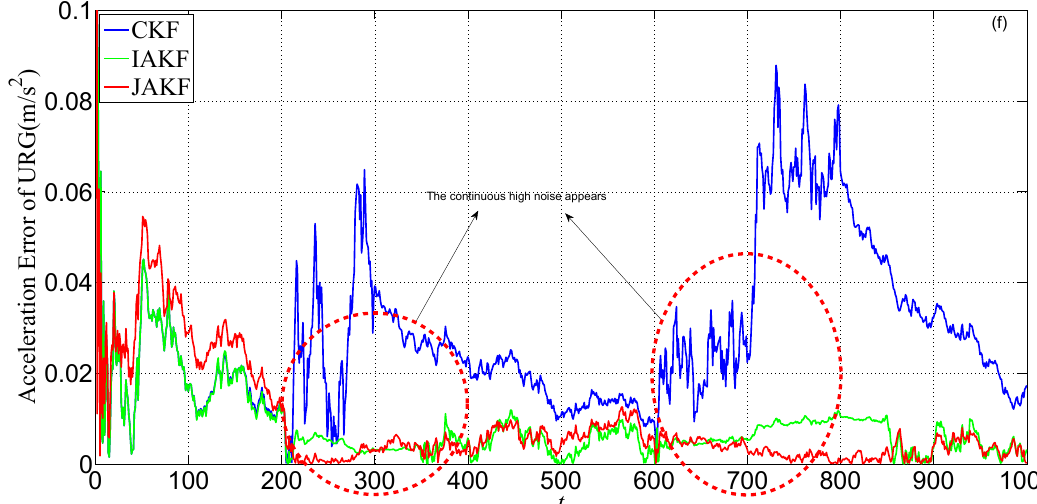
Figure 18. Estimation and error comparison of URG in the third experiment: ( a ) Displacement estimation of URG; ( b ) Displacement error of URG; ( c ) Velocity estimation of URG; ( d ) Velocity error of URG; ( e ) Acceleration estimation of URG; ( f ) Acceleration error of URG.